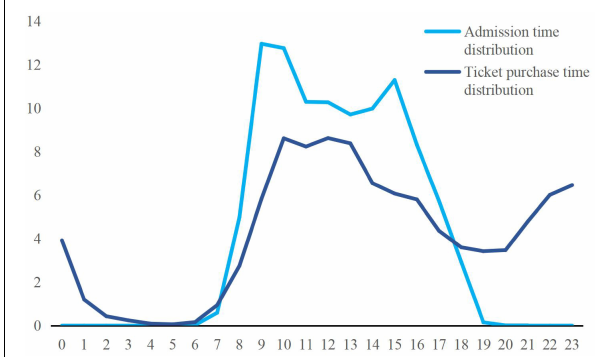
FIGURE 1 | Single-day time distribution of ticket purchase and admission in Nanning Daming Mountain Scenic Area.